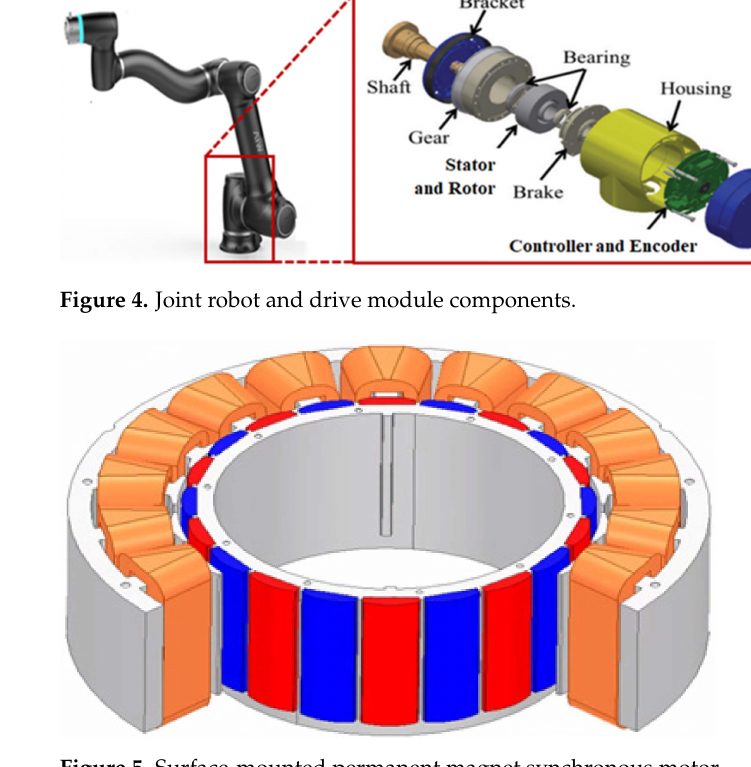
Figure 5. Surface-mounted permanent magnet synchronous motor.